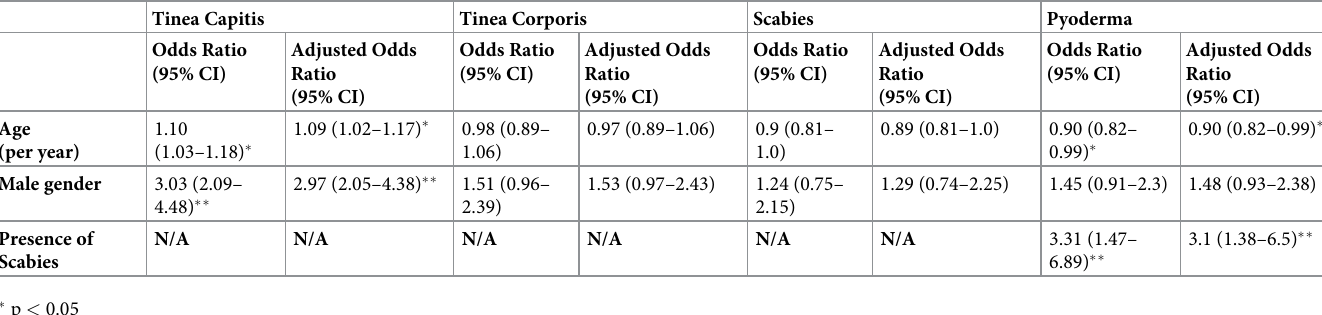
Table 1. Association between demographic factors and common skin dermatoses during the dry season survey.